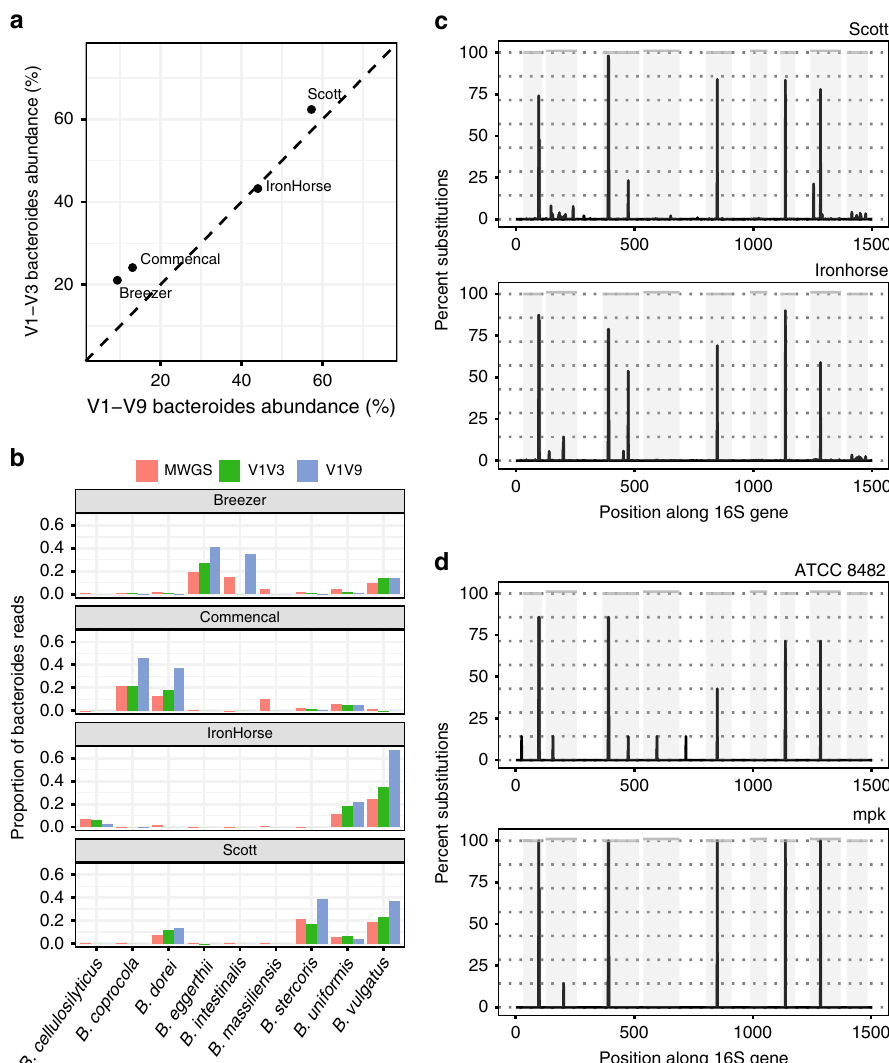
Fig. 3 Detecting Bacteroides in human stool samples. a The relative abundance of the genus Bacteroides in four human stool samples quanti fi ed using either V1 – V9 amplicons ( x -axis) or V1 – V3 amplicons ( y -axis). b The relative abundance of Bacteroides species in the same four samples. Species abundance was quanti fi ed from mWGS sequencing or from V1 – V3/V1 – V9 OTUs generated at 99% identity. Abundance is shown for the most abundant species as quanti fi ed by mWGS (for abundance estimates of all Bacteroides species detected by each platform, see Supplementary Table 5). c Nucleotide substitution pro fi les generated by aligning all V1 – V9 amplicon sequences assigned to the single OTU identi fi ed as Bacteroides vulgatus . Pro fi les are shown for the two stool samples with high B. vulgatus relative abundance (IronHorse and Scott). d Nucleotide substitution pro fi les predicted from the reference genomes of two different B. vulgatus strains ATCC 8482 39 and mpk 40 . In both c and d , nucleotide substitutions were identi fi ed relative to a single reference 16S gene for B. vulgatus ATCC 8482 (NCBI Gene ID 5304800). Gray panels depict variable regions de fi ned by commonly used primer-binding sites (Supplementary Table 1). Dashed lines indicate the expected proportion of nucleotide substitutions, given there are seven 16S gene copies within each genome. Source data are provided as a Source Data fi